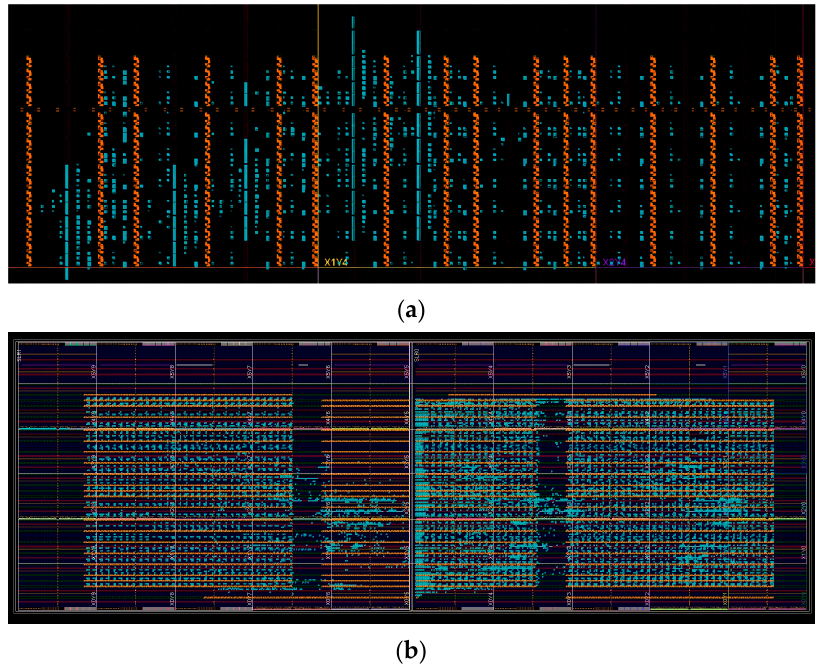
Figure 1. The implementation result of the proposed systolic array with a dimension of ( a ) 16 × 16 and ( b ) 64 × 64. DSPs used are marked in orange.